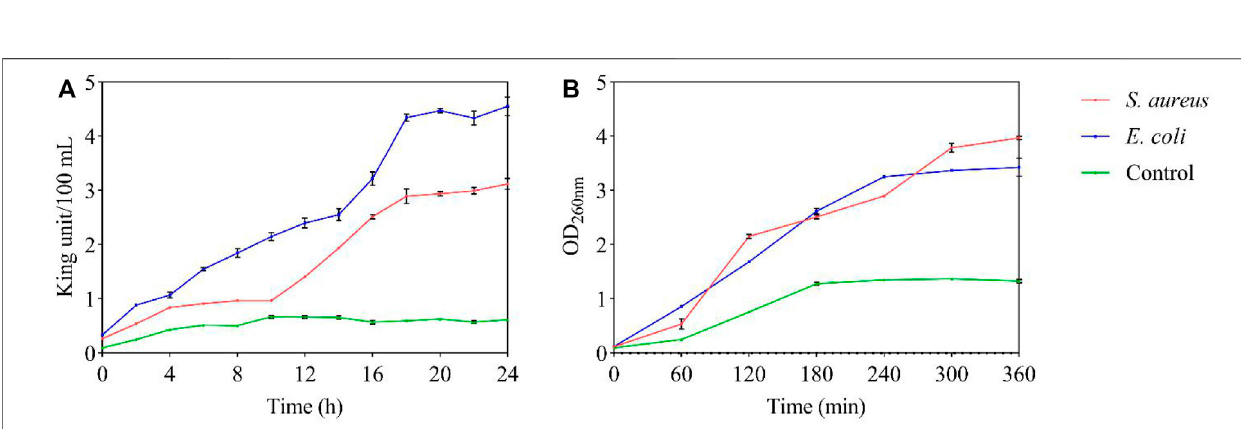
Frontiers in Pharmacology |